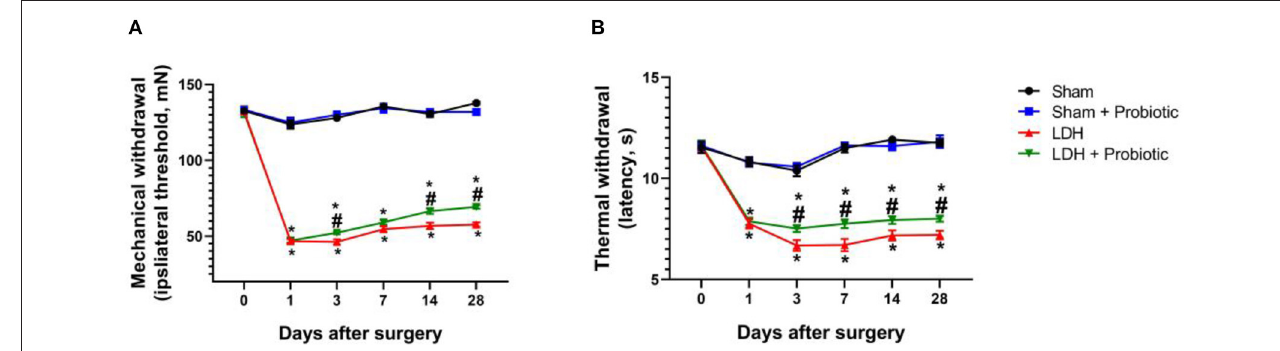
FIGURE 1 | L. paracasei S16 alleviated the behavior in LDH mice. (A) Mechanical withdrawal; (B) Thermal withdrawal. Data were expressed as the mean ± SEM. * P < 0.05 vs. Sham; # P < 0.05 vs. LDH.